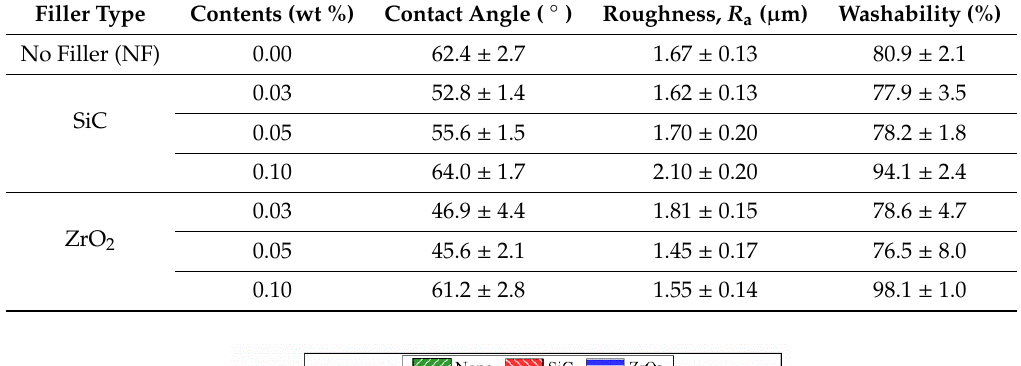
Table 4. A summary of evaluated properties for ceramic filler (SiC or ZrO 2 )-added enamel scales.